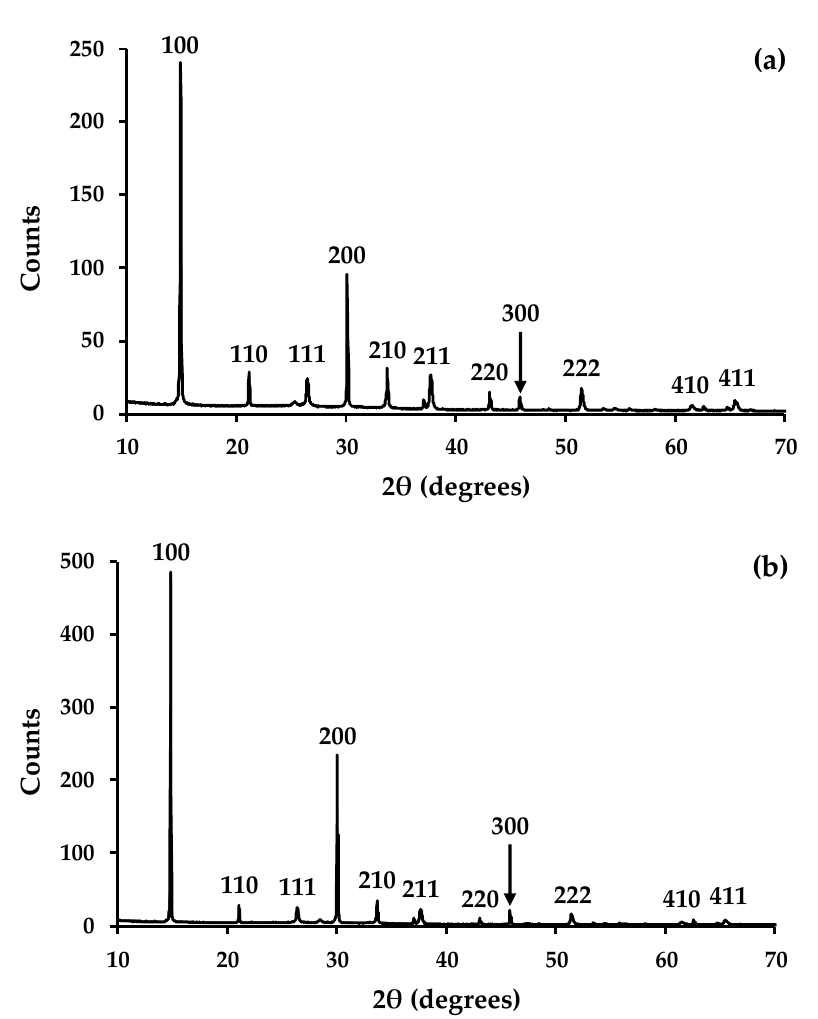
Figure 7. X ‐ ray diffraction data of CH3NH3PbBr3 deposited on a TiO 2 scaffold layer ( a ) as made and Figure 7. X-ray di ff raction data of CH3NH3PbBr3 deposited on a TiO 2 sca ff old layer ( a ) as made and ( b ) after 24 h exposure to UV light and 70% relative humidity. ( b ) after 24 h exposure to UV light and 70% relative